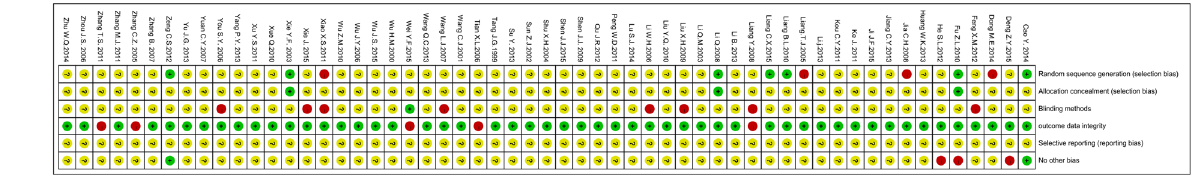
Figure 3. The risk of bias